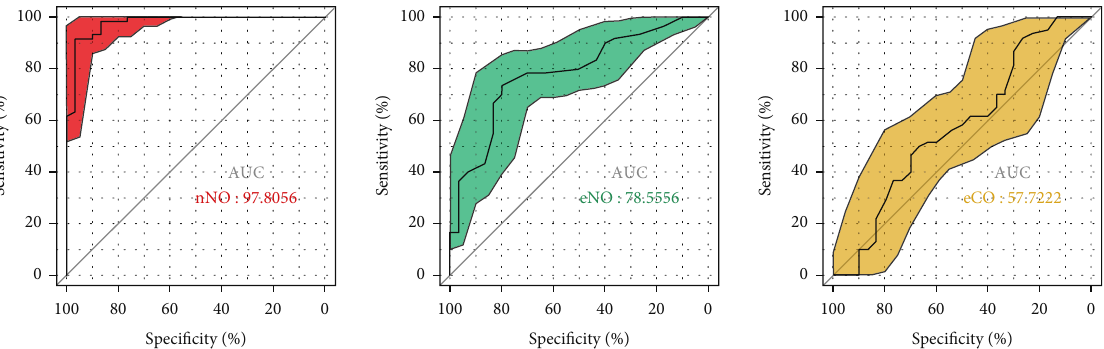
Figure 4: ROC curve of the nNO, eNO, and eCO levels for AR diagnosis. The AUC of the three indicators is all higher than 50%, which proved that the three indicators are both valuable in the detection of AR. The AUC of nNO is 97.8%, which is close to 100%. It shows that nNO has high value in AR